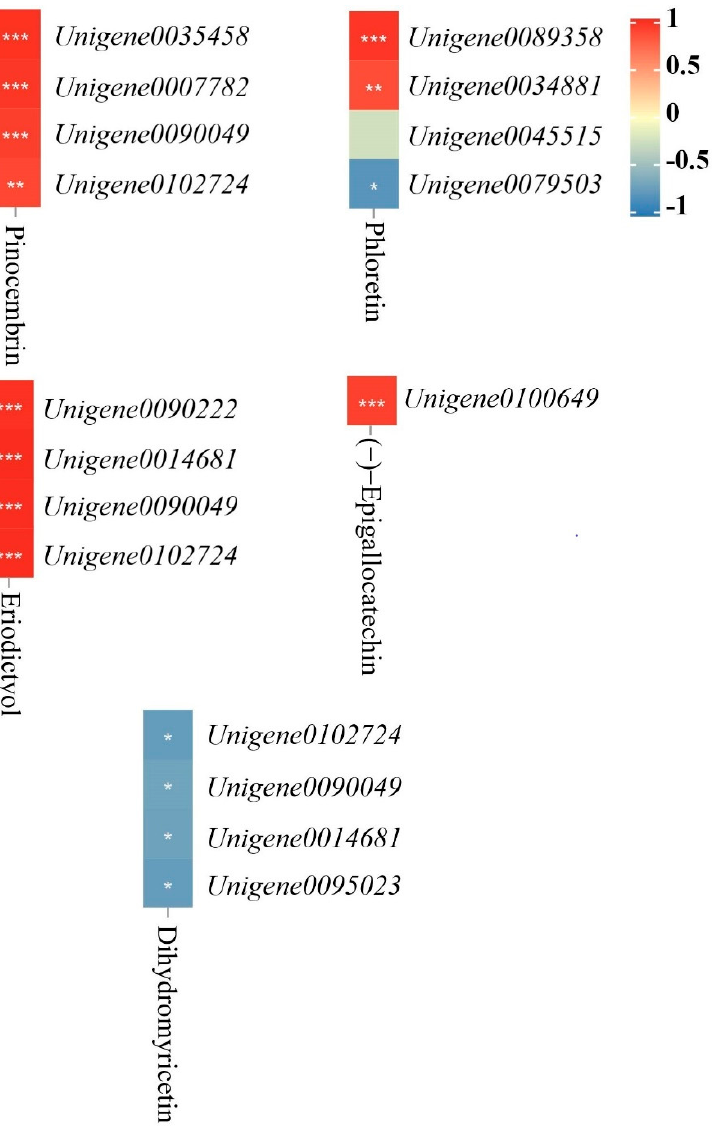
Figure 4. Heatmap of the correlation between DEGs and differential metabolites in the flavonoid biosynthesis pathway. (Heatmap of correlations between DEGs regulating differential metabolites in the flavonoid biosynthesis pathway and their differential metabolites. Note: p ≥ 0.05 is not marked; 0.01 < p < 0.05 is marked as *; 0.001 < p < 0.01 is marked as **; p ≤ 0.001 is marked as ***).